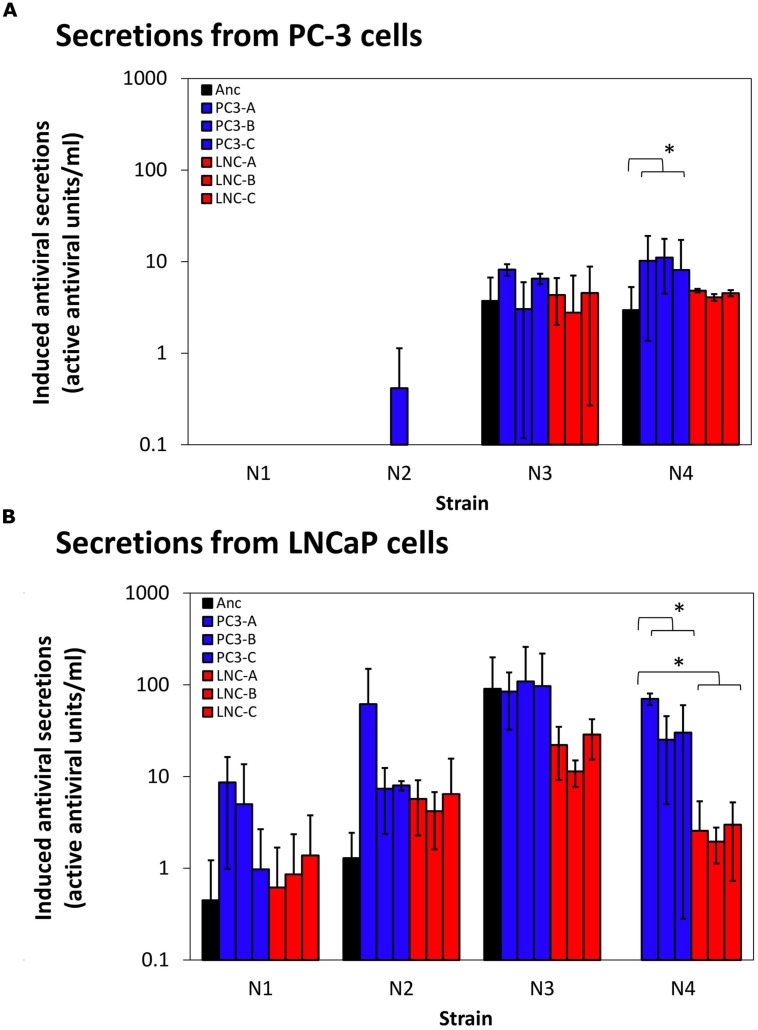
Induction of auto/paracrine antiviral signaling by ancestor and evolved virus strains. Antiviral paracrine signaling activity secreted into supernates above virus-infected cells [PC-3 cells, (A), LNCaP cells, (B)] are shown. Data shown are mean and SD of three biological replicates for each evolved strain shown. Secreted activity due to ancestor strain infections are shown in blue, PC-3-evolved strains in reds, and LNCaP-evolved strains in greens. ∗p < 0.05.